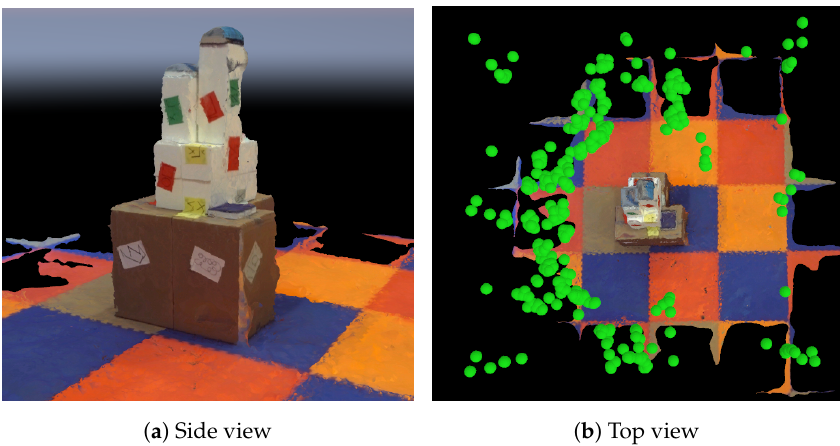
Figure 15. The 3D reconstructed representative model utilizing the collected images during the NBV mission. The locations of the gathered images are presented in green dots.